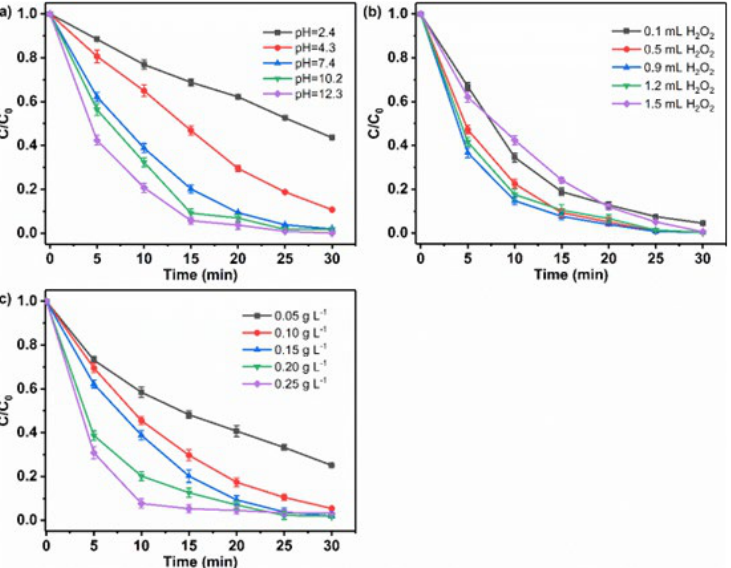
Figure 10. The effect of ( a ) pH, ( b ) amount of H 2 O 2 and ( c ) catalyst dosage on degradation of MB in MCA-CN/WO 3 /H 2 O 2 /visible light system. MCA-CN/WO 3 /H 2 O 2 /visible light